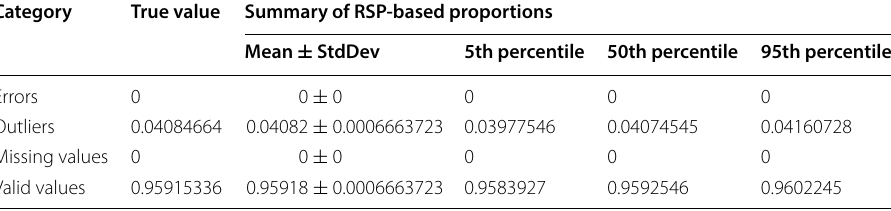
RSP-based proportions were calculated from a sample of RSP blocks ( g = 15 )